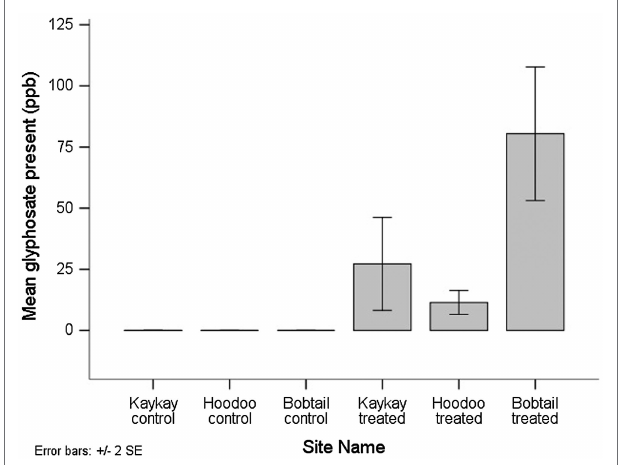
FIGURE 5 | The average amount of glyphosate residue present in R. acicularis flowers collected from operational forestry cutblocks 2 years after they were treated with GBH in northern BC, Canada. Standard errors are